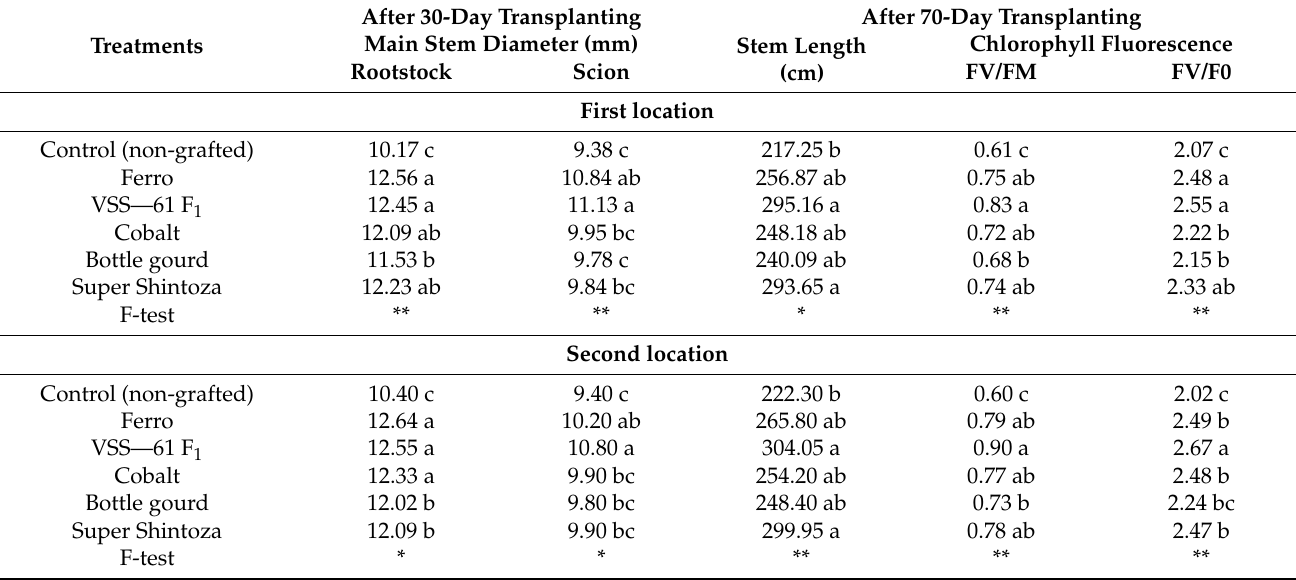
Table 2. Response of main stem diameter, stem length and chlorophyll fluorescence to grafting on different rootstocks after 30 and 70 DAT to heat stress in both experimental